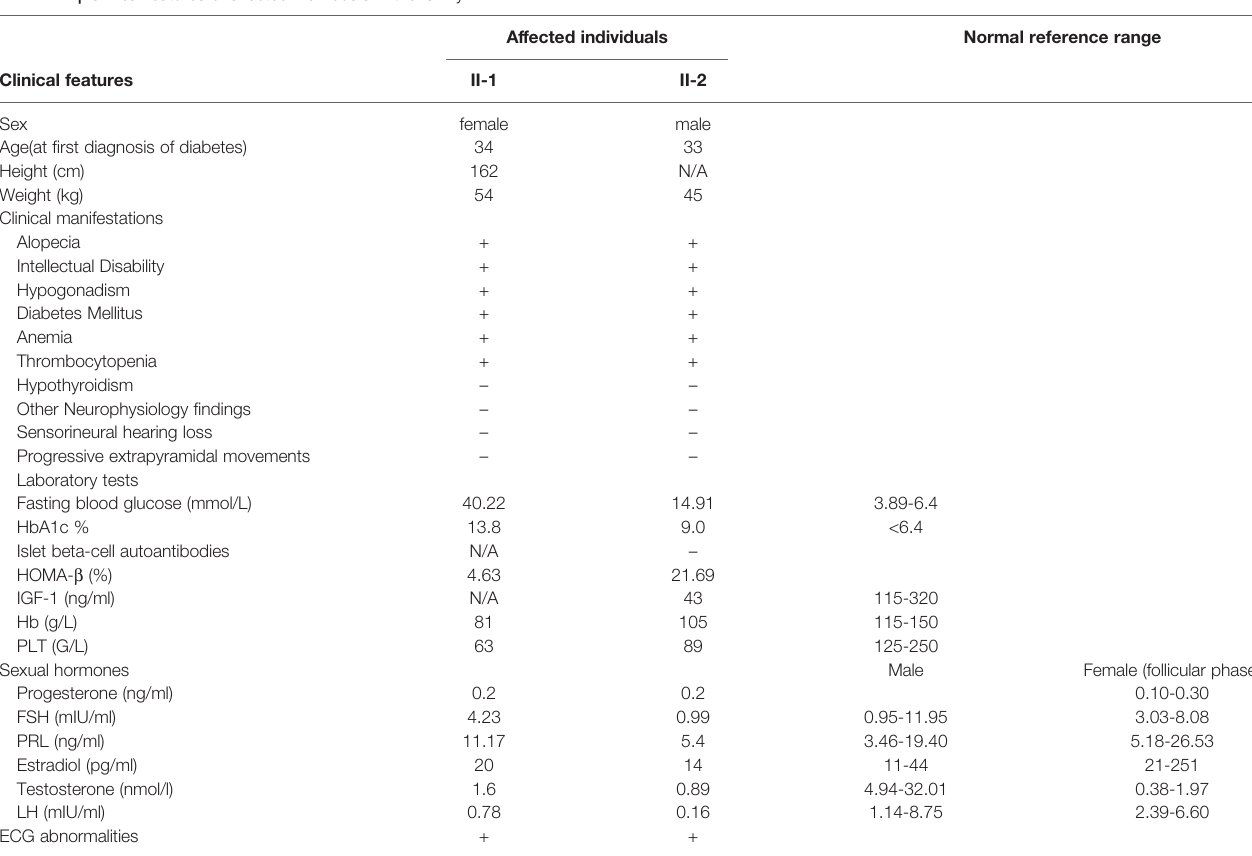
TABLE 1 | Clinical features of affected individuals in the family. Affected individuals Normal reference